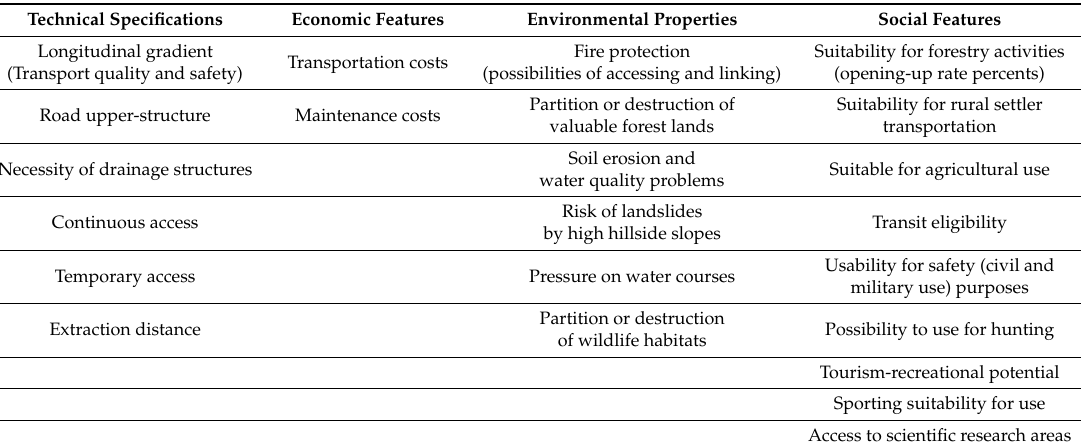
Table 1. The factor groups and sub-factors evaluated for forest road